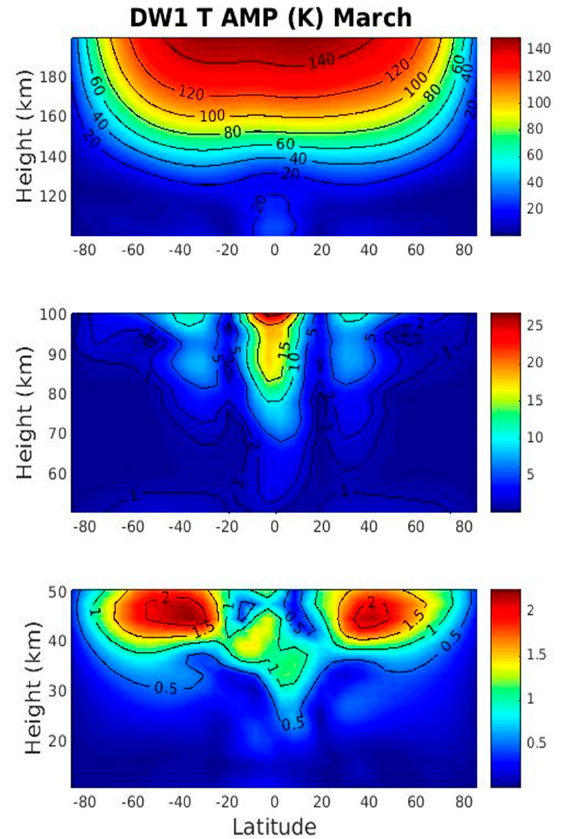
Figure 1. Climatological mean latitude-height structure of DW1 (the migrating diurnal tide) amplitude in the stratosphere (bottom panel), mesosphere (middle panel) and thermosphere (top panel) for temperature T (K) in March from the eCMAM30 (1979–2010).